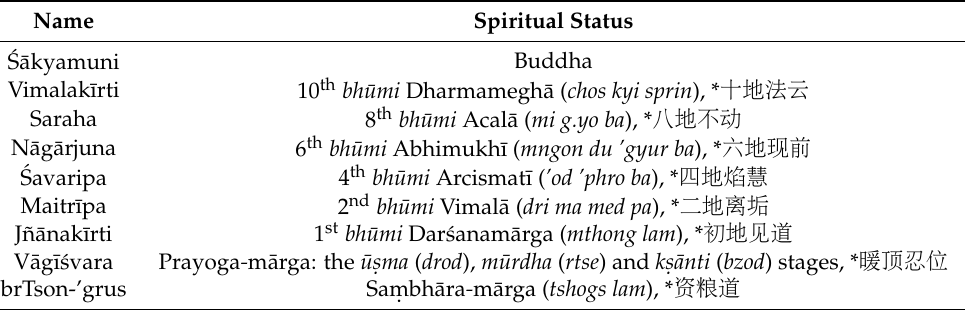
Table 2. Spiritual status of patriarchs in the Keypoints